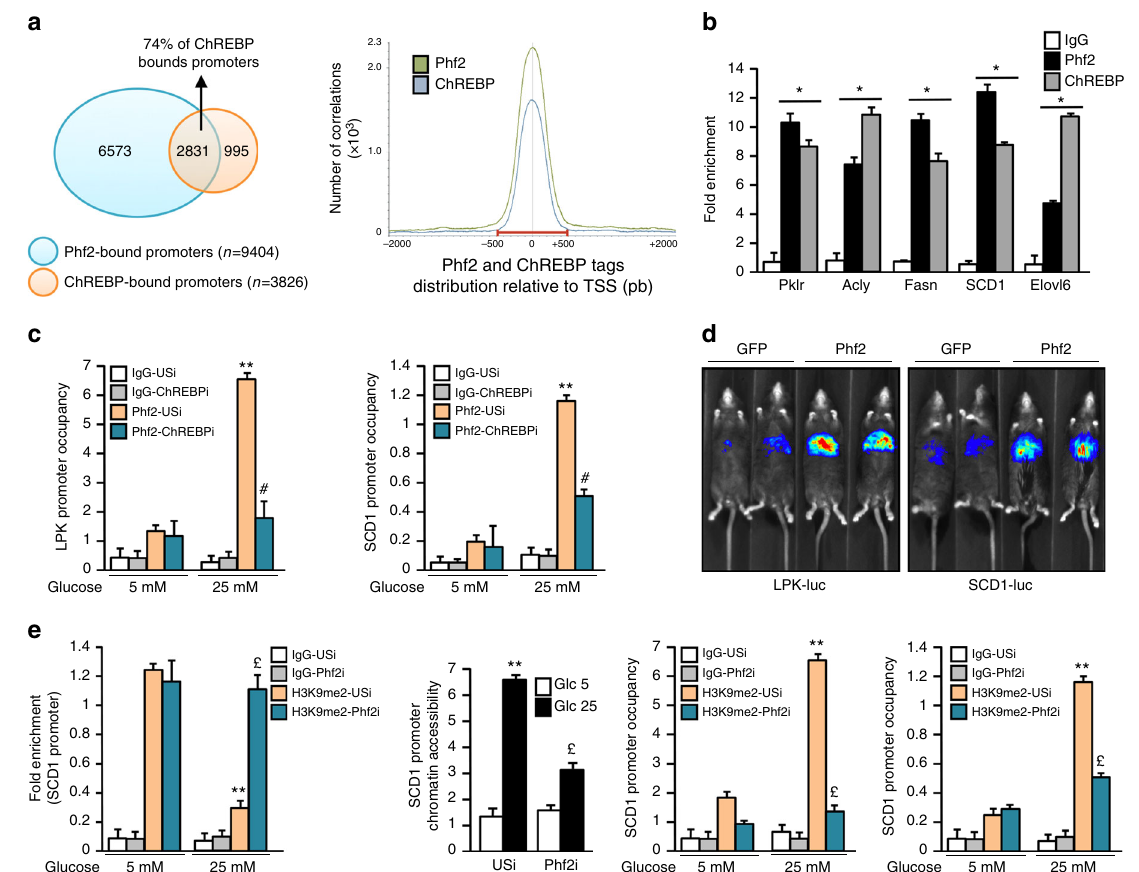
Fig. 4 Phf2 acts as a new ChREBP transcriptional co-activator in hepatocytes. a Venn diagram of overlap between Phf2 and ChREBP ChIP-seq peaks on promoters in primary hepatocytes (left panel). Distribution of Phf2 and ChREBP ChIP-seq tags density in the vicinity of the TSS (right panel). b In vivo